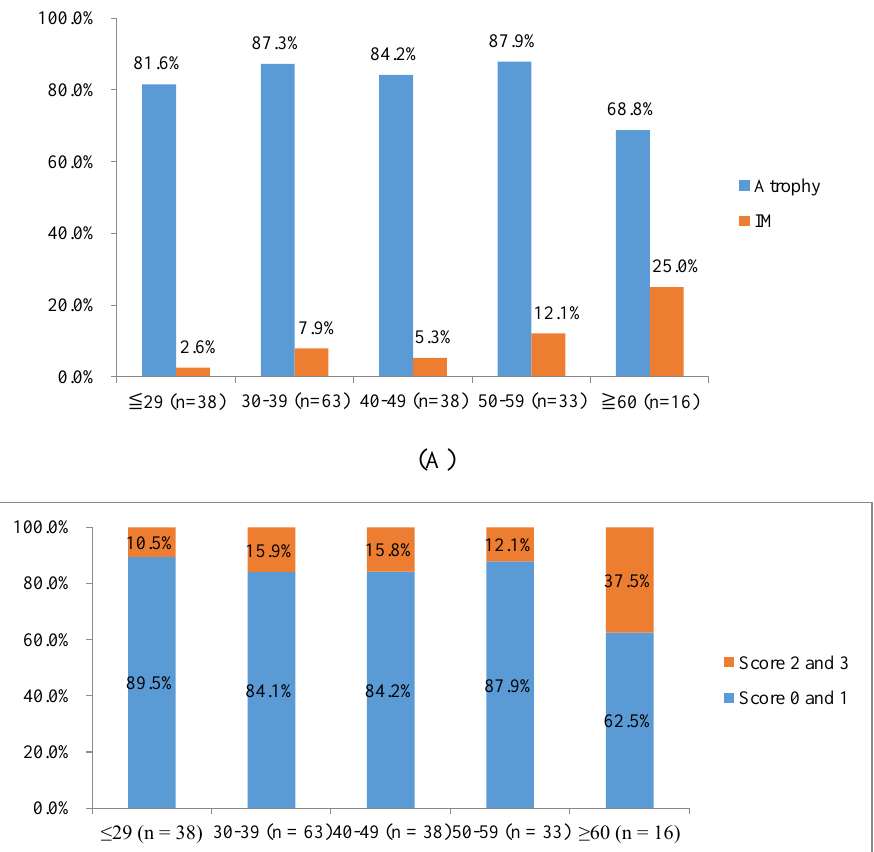
Figure 2. H. pylori and histology. ( A ) The distribution of atrophic gastritis (atrophy) and intestinal metaplasia (IM) based on age groups within H. pylori infected subjects. ( B ) The distribution of OLGA score (high risk: OLGA 2 and 3, and low risk: OLGA 0 and 1) based on age groups within H. pylori -infected subjects.